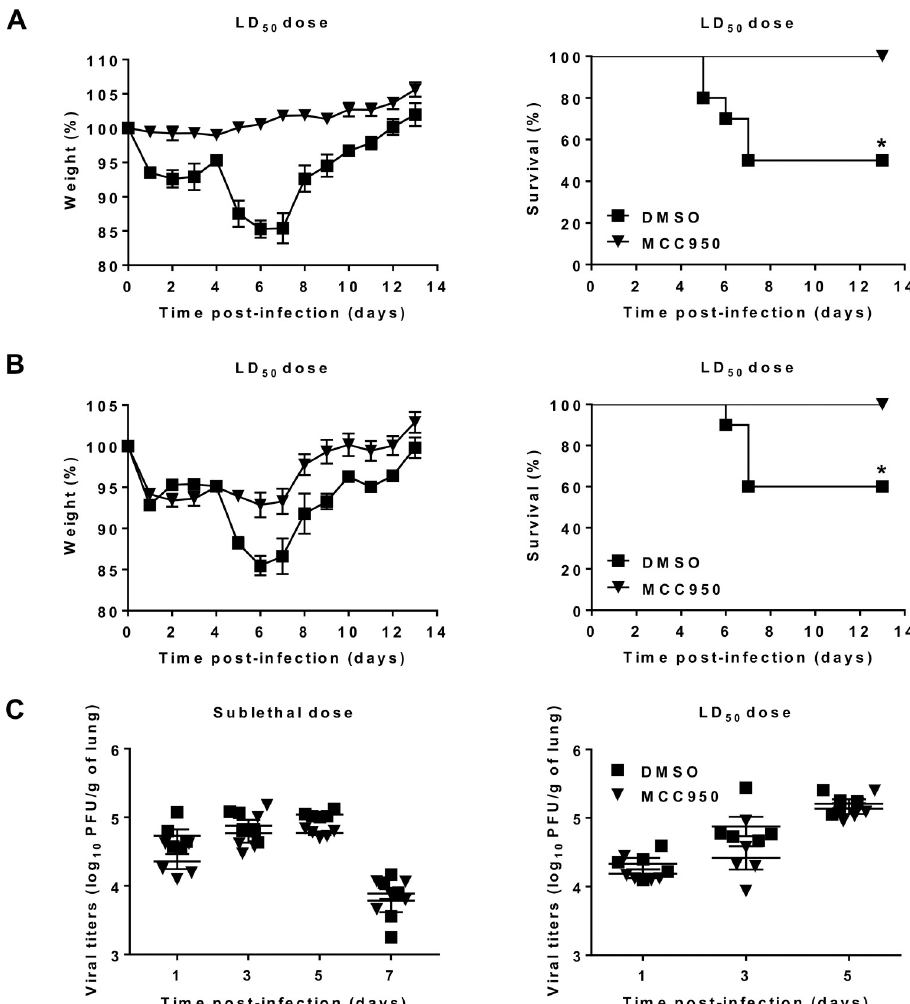
Fig 2. NLRP3 inflammasome contributes to the pathogenesis of HMPV. BALB/C mice were inoculated with HMPV at a